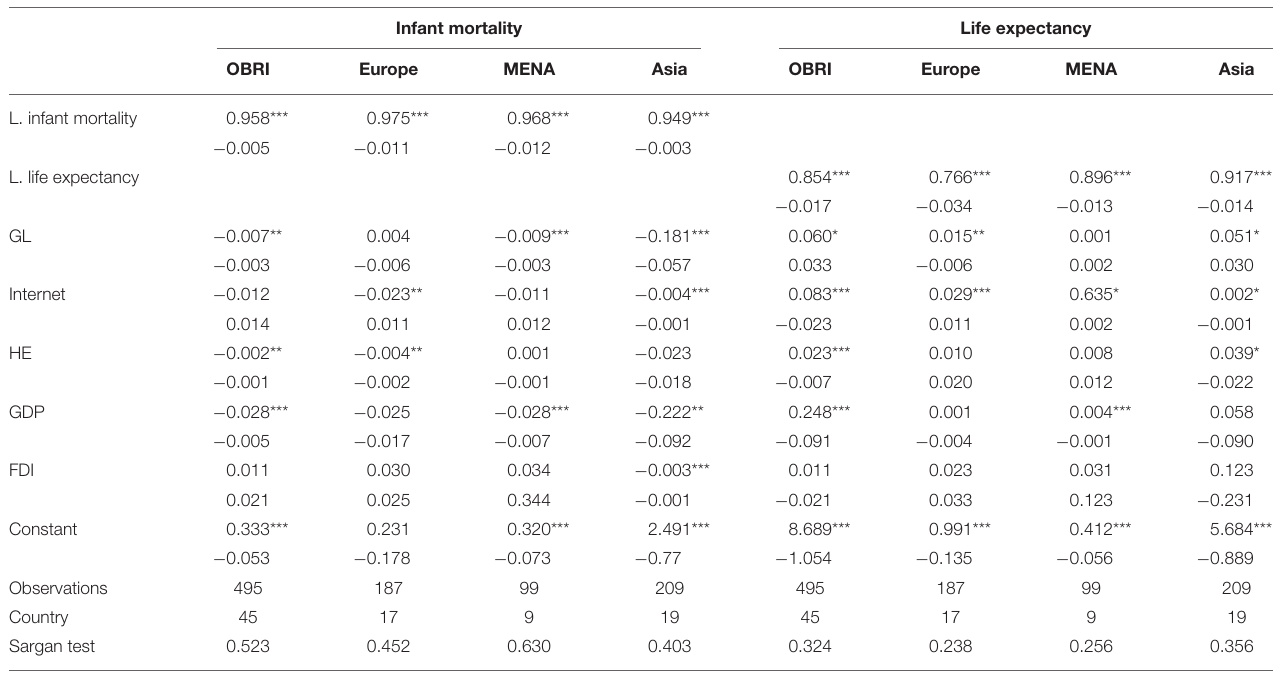
TABLE 4 | Health outcomes